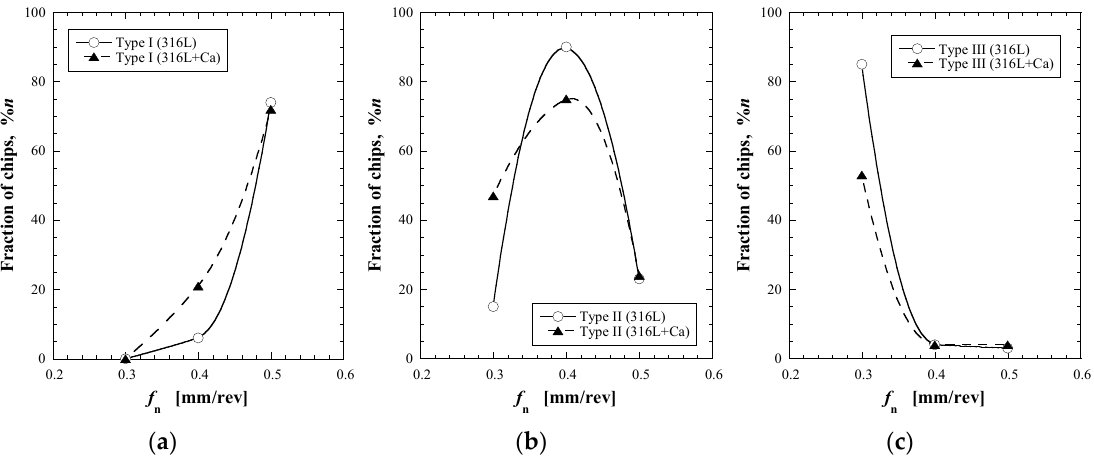
Figure 4. Chip weight distributions for Type I ( a ), Type II ( b ) and Type III ( c ) chips obtained at an a p value of 3 mm and a cutting speed of 130 m/min.